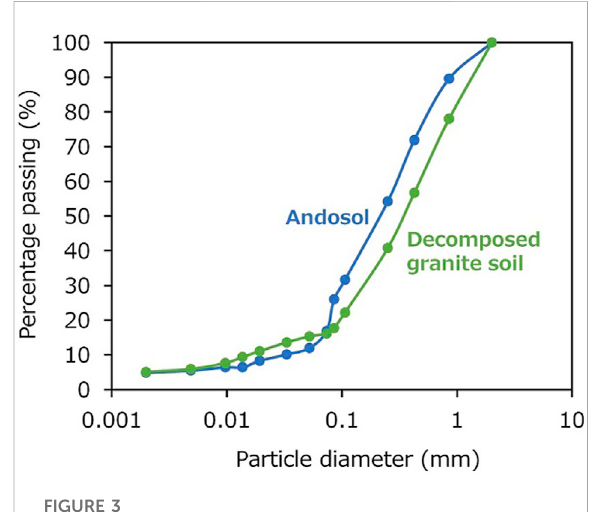
FIGURE 3 Particle size distribution curves for andosol and decomposed granite soil after sieving, to adjust the particle size of the soil samples for the experiment.